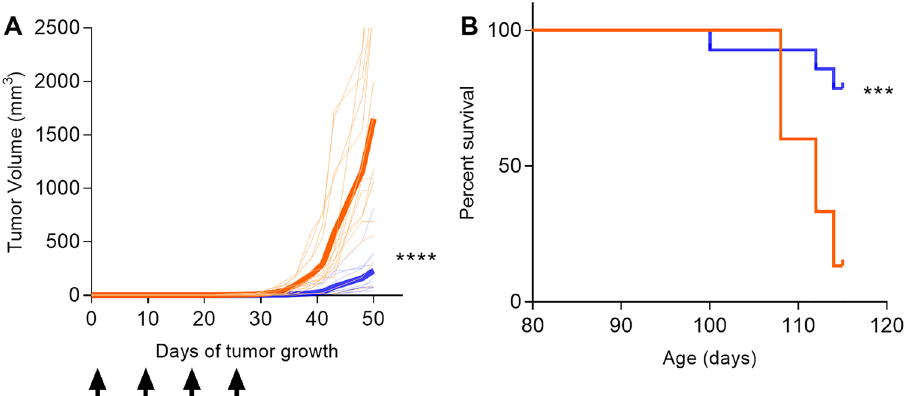
Figure 4. The Th1 selective multiantigen vaccine, administered after tumor implant, limits prostate cancer growth and increases overall survival. ( A ) Tumor volume from mice immunized with adjuvant alone (orange lines) or the multi-antigen vaccine (blue lines). Volume for individual mice (n = 15/group) is presented in thin lines and the mean volume is presented as the thick line. Arrows indicate when the vaccines were administered. ( B ) Kaplan Meir curve for percent survival from mice immunized with adjuvant alone (orange line) or the multiantigen (blue line). n = 15 mice/group; ***p < 0.01, ****p <